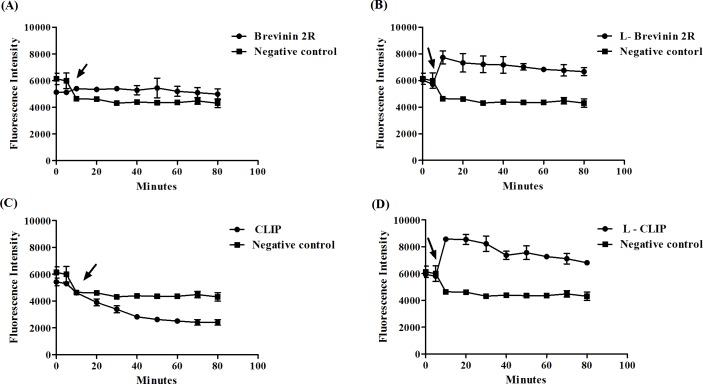
Cell membrane potential changes in L. major promastigotes exposed to (A) Brevinin 2R, (B) L- Brevinin 2R (C) CLIP and (D) L-CLIP. Arrow shows the time of peptides addition.